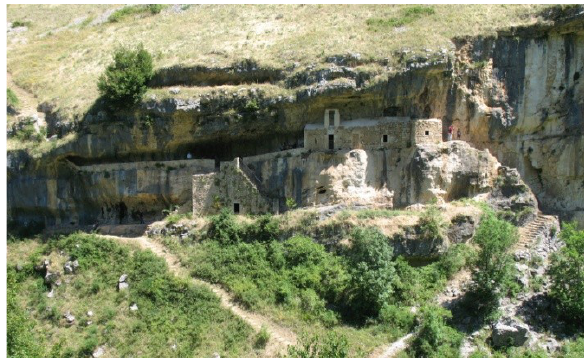
Figure 2. View from the valley in front of the hermitage